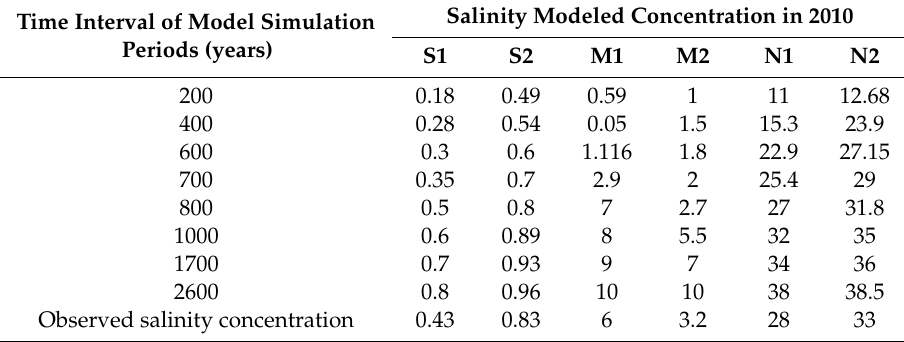
Figure 6. The salinity concentration values in kg/m 3 for six points (S1, S2, M1, M2, N1, and N2) in the period 1980–2010, compared to their observed salinity concentration values for different simulation periods. Table 2. The salinity modeled concentration values in kg/m 3 for six points (S1, S2, M1, M2, N1, and N2) in 2010, compared to their observed salinity concentration values for different simulation periods.